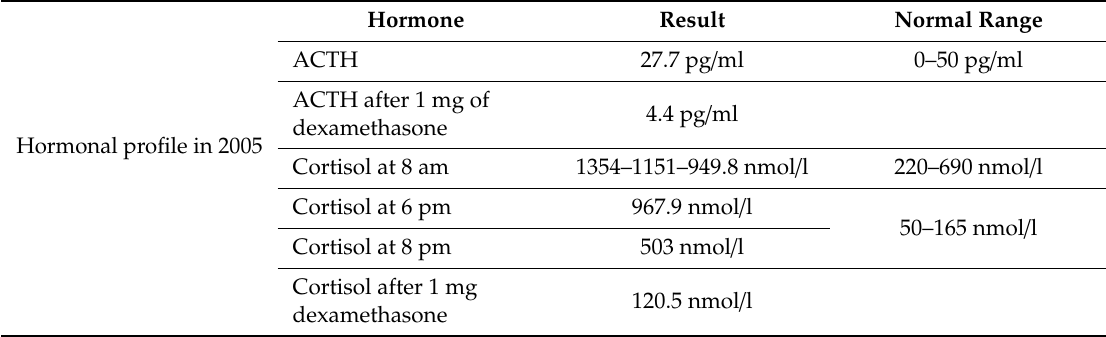
Table 1. Concentrations of chosen hormones in the described patient in